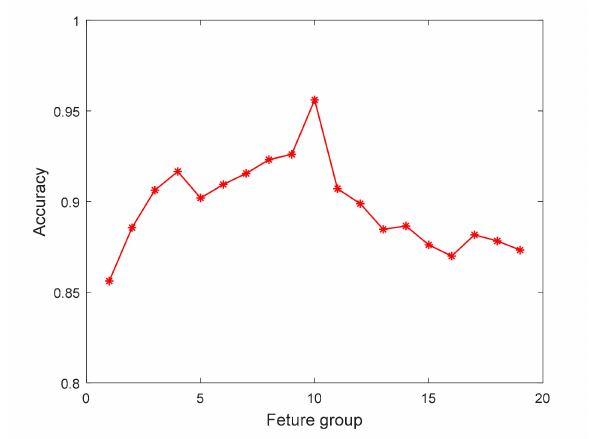
Figure 7. Relationship between features combination and blades icing recognition